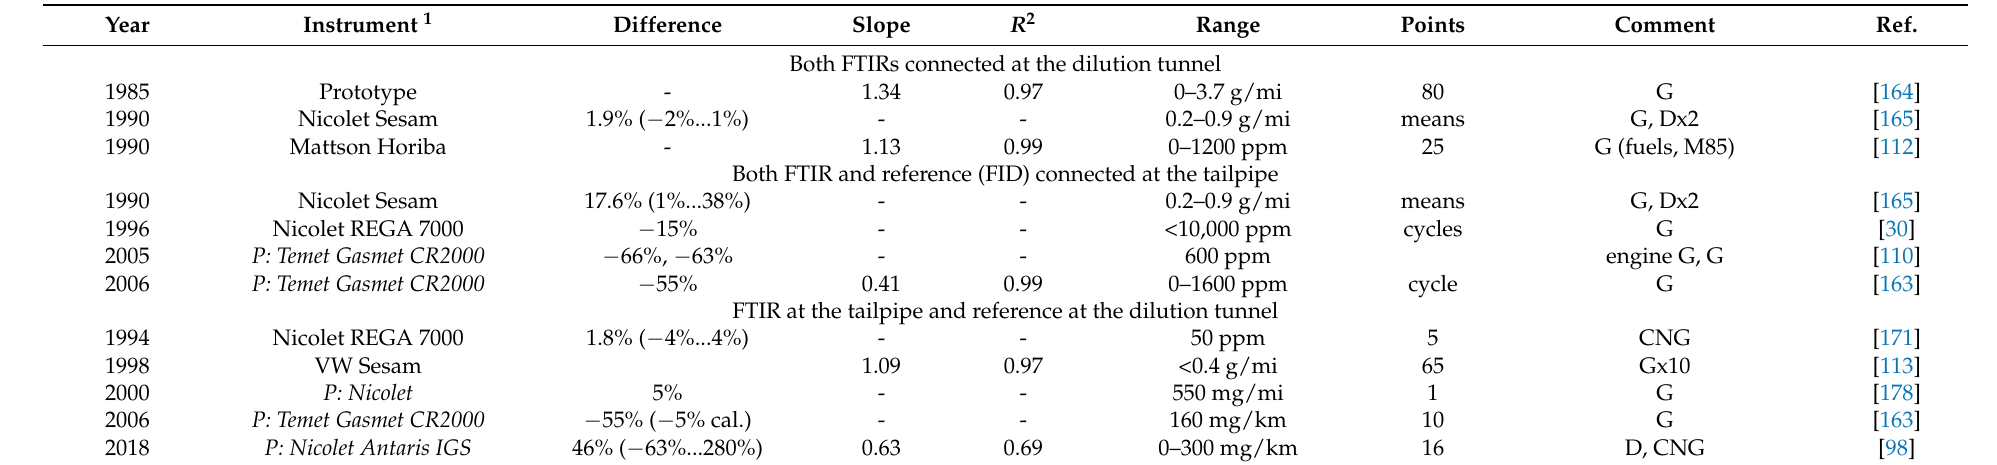
Table A5. Comparisons of FTIR with THC analyzers